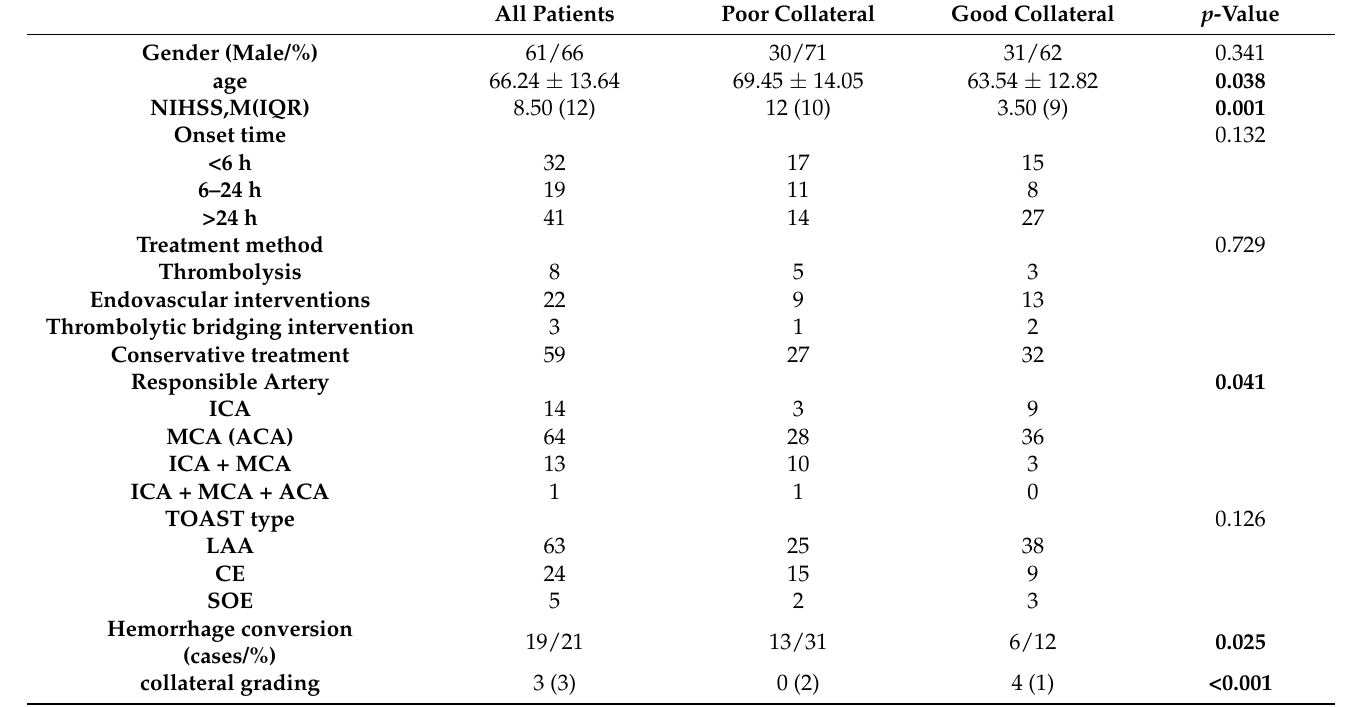
Table 1. The description and comparison of clinical characteristics between groups with good or poor collateral circulation.